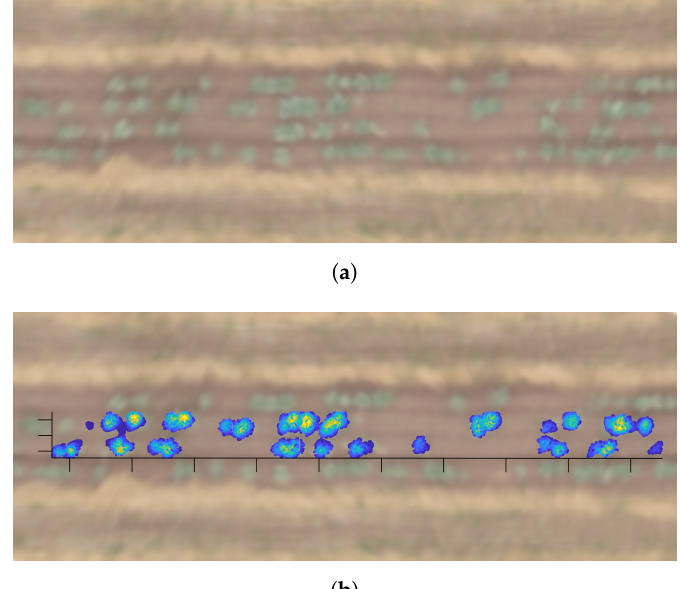
Figure 5. A part of the drone image zoomed into one of the measured strips, shown both without ( a ) and with ( b ) an overlay of the points identified by the algorithm as vegetation. The quality of the image is not optimal but the correct identification of the vegetation in the central row is visible. In ( b ) the colours correspond to the value of the weighted sum in each of the